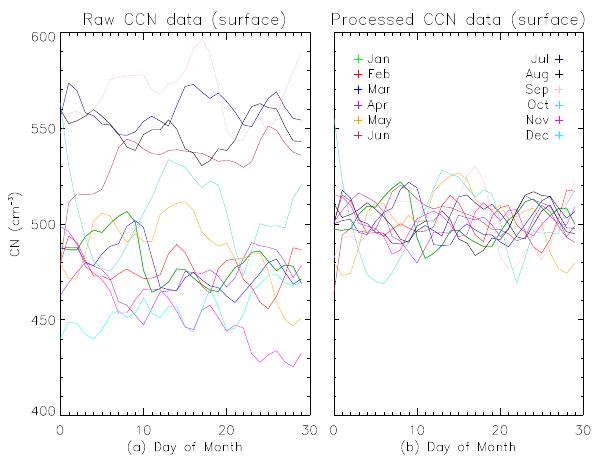
Fig. 2. Time series of unprocessed (left panel) and processed (right panel) surface CCN 70 concentrations. The removal of the trend makes it possible to analyse the 12 samples together, but the intra- sample variance remains unchanged. The ensemble mean has been added back to each data set for graphical purposes.